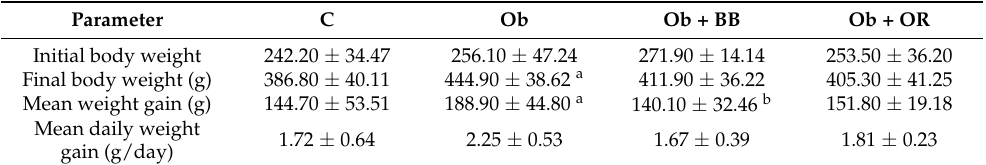
Table 2. Body weight and related parameters in all